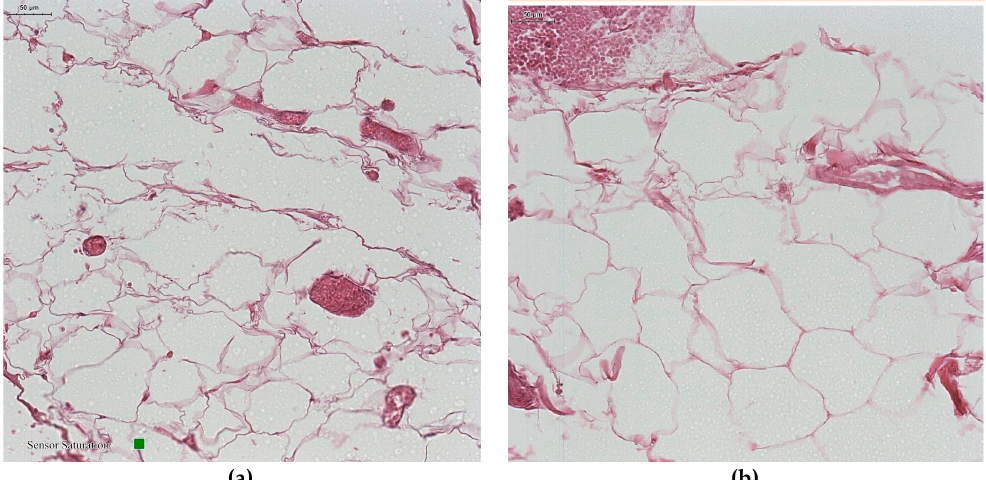
Figure 3. Histopathological images. Blood vessels, adipose tissue. ( a ) control group (non-obese pa- tient); ( b ) obese patient (H&E staining).